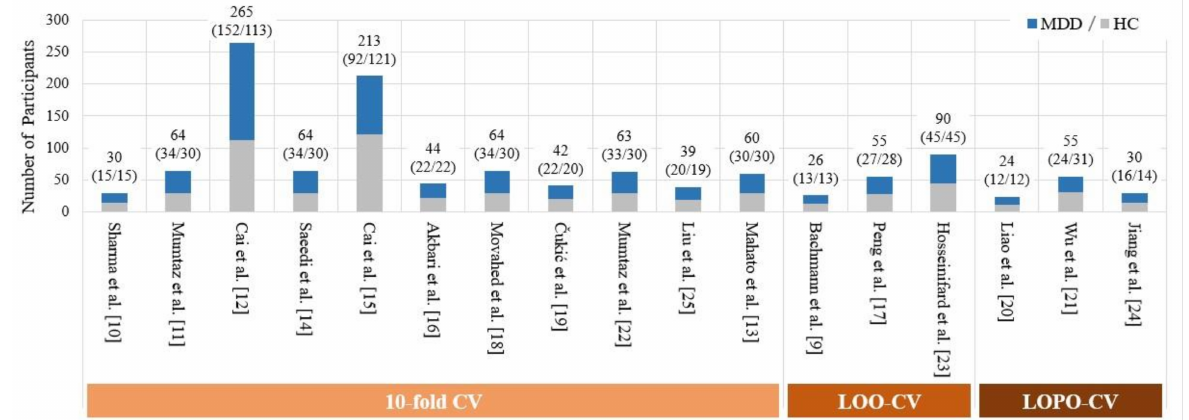
Figure 1. Comparison of the number of subjects in previous EEG- and ML-based studies. Directly performing a 10-fold CV on the group of participants (i.e., partitioning the entire group into 10 folds, with no EEGs of the same participants appearing in different folds at the same time) is nearly impossible due to participant size limitations. As a result, the k-fold CV is often performed on the EEG samples rather than participants. As an example, Movahed et al. [18] used a public EEG dataset (34 MDD, 30 HC) [36] and, for each participant, two EEG episodes of 5 min (eyes open and eyes closed) were collected.